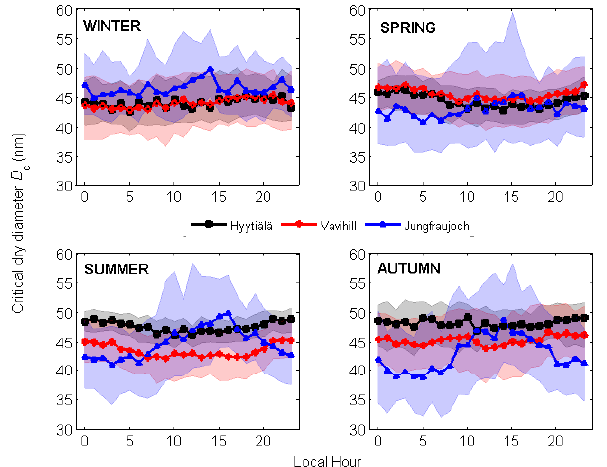
Figure 8. Hourly median critical dry diameters D c at the S eff of 1.0% for three long-term measurement locations separated by sea- sons. Shaded areas represent the 25th and 75th percentiles, with colours corresponding to the median data